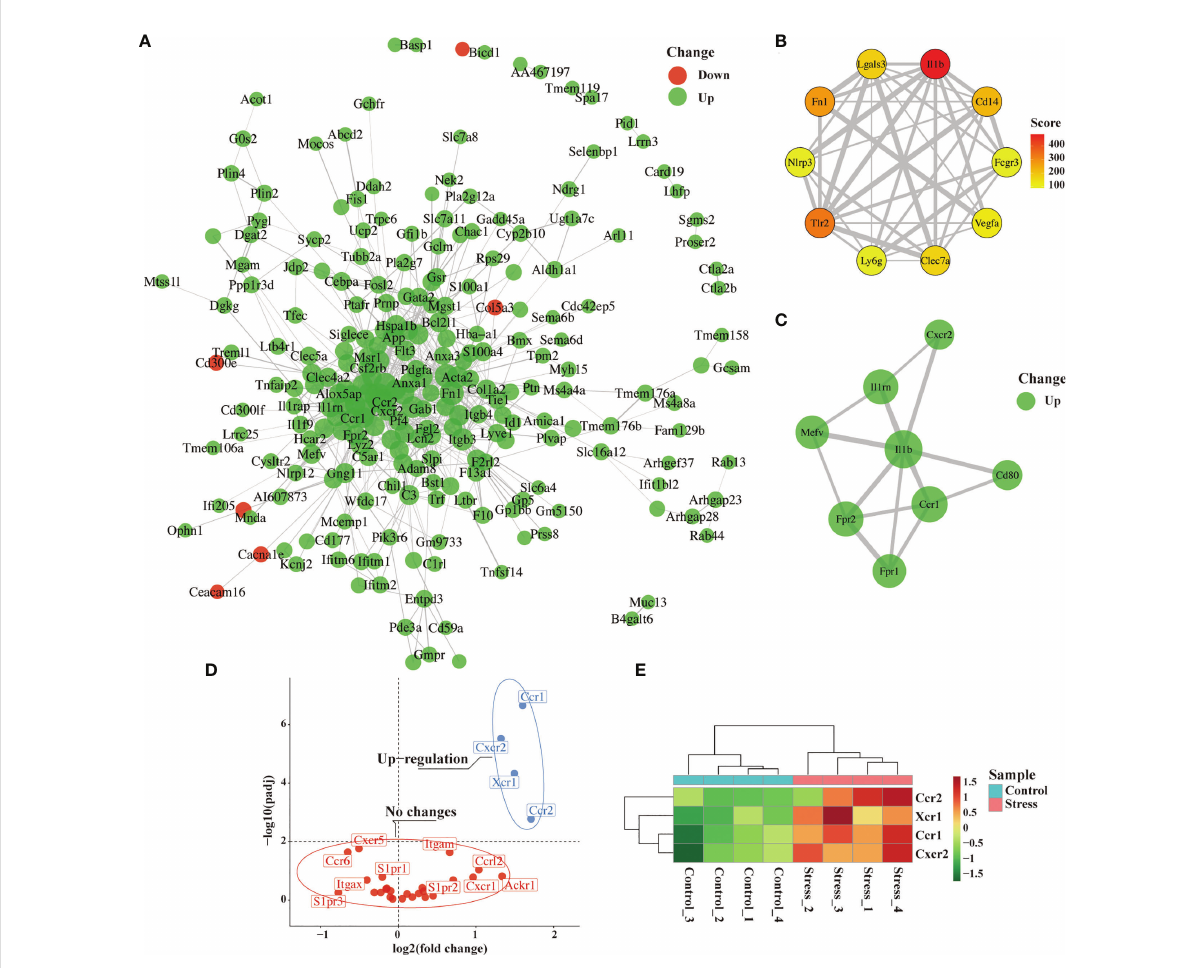
FIGURE 5 Identi fi cation of hub genes and analysis of migration-related genes from DEG. After 6 hours of restraint stress or no stress (n=4, per group), RNA extracted from peripheral blood was sequenced and analyzed. (A) The selected DEG were used for PPI network analysis online. (B, C) Hub gene and modules were screened from PPI network through Cytoscape software. (D, E) Genes related to cell migration or chemotaxis were analyzed and visualized by volcano graph and heatmap